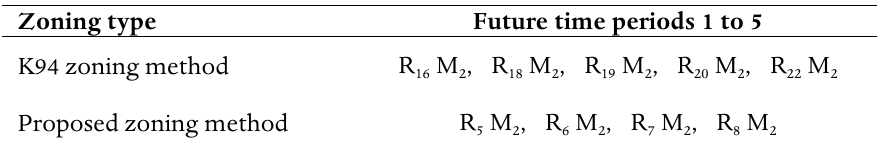
Table 4. Deterministic forecasting matrix during the first to fifth time periods for zoning by K94 and by the proposed zoning.